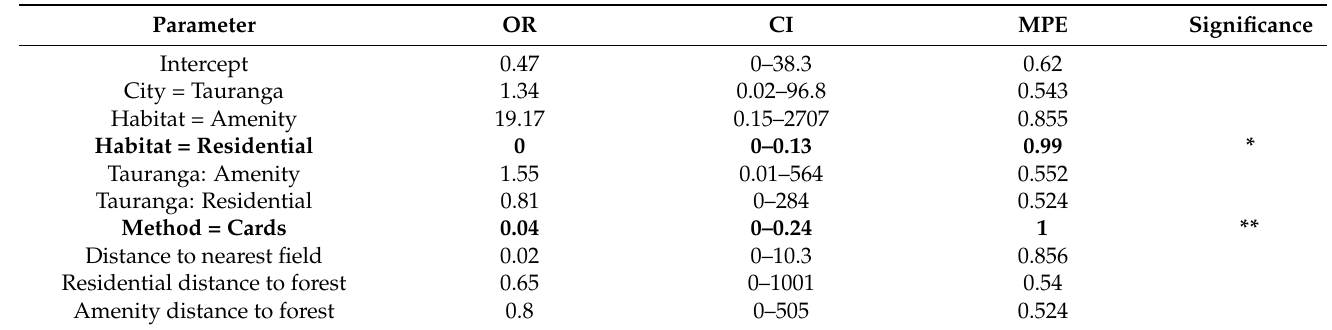
Table 6. Rats: summary statistics for coefficients of the parameters in the two-city rat model fitted to data from New Plymouth and